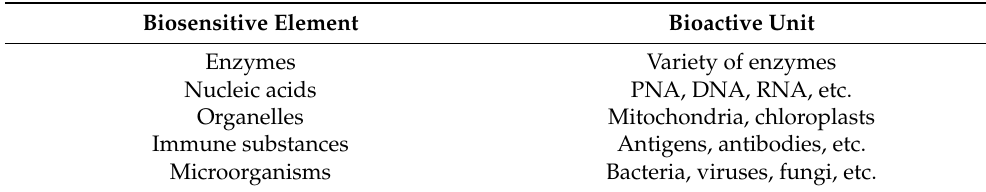
Table 1. Biomolecular recognition devices.